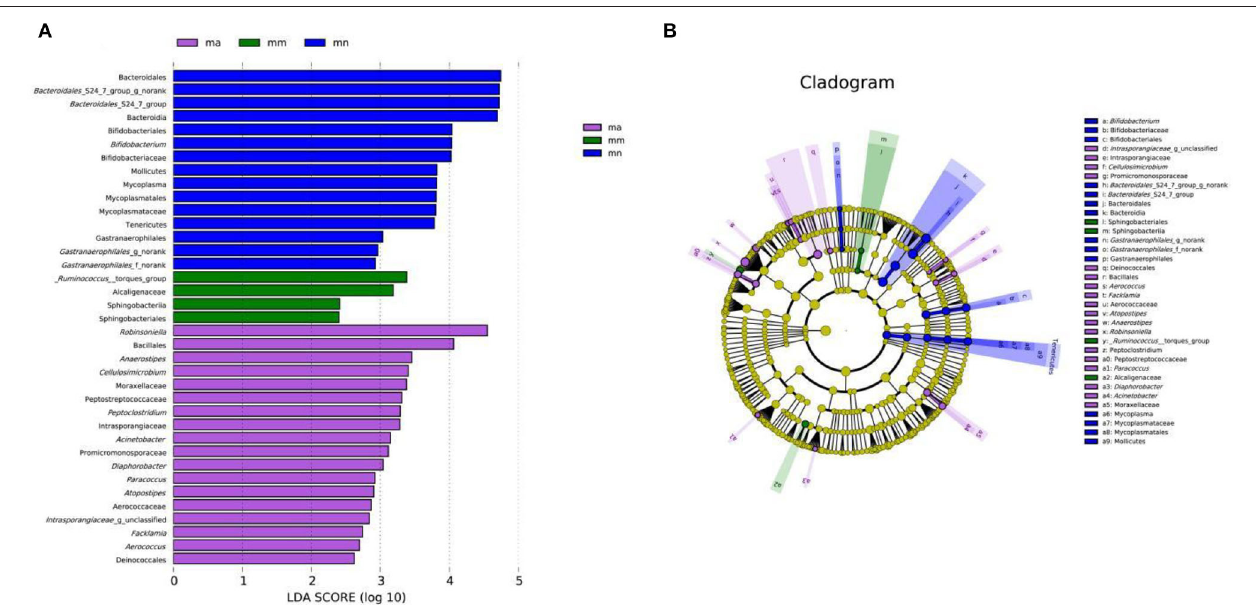
FIGURE 7 | Effect of QWBZP crude polysaccharide on the characteristic intestinal mucosal bacteria. Green, blue, and purple represent the mn, mm, and ma groups, respectively. (A) LDA score plot. (B) LEfSe